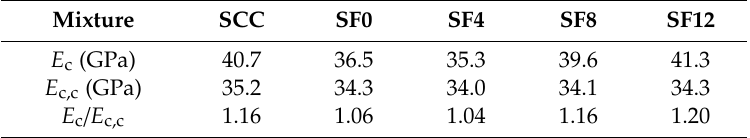
Table 9. Tested and calculated values of the modulus of elasticity of specimens. Mixture SCC SF0 SF4 SF8